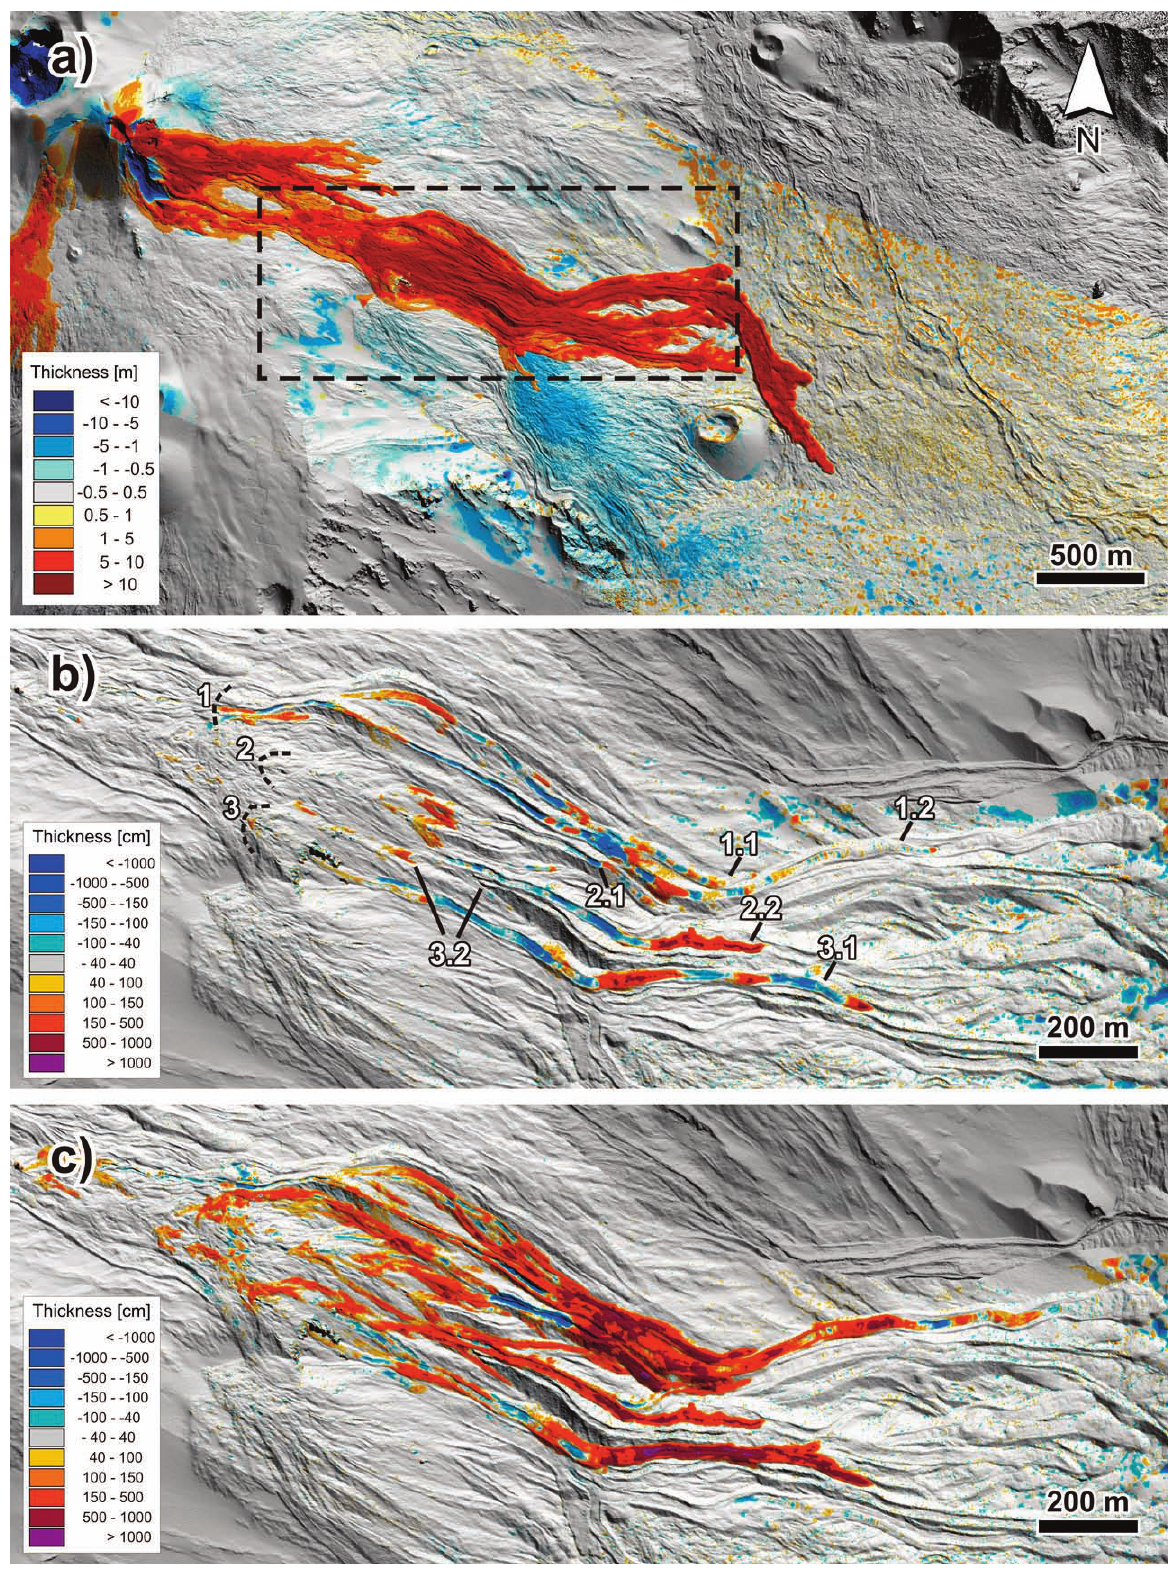
Figure 1. a) 2006-2005 DEM difference map calculated from the LIDAR datasets of INGV-Pisa, showing the extent of the eastern lava field (in warm colors – yellow, orange, red) of the 2006 eruption at the beginning of the 2006 LIDAR survey; b) and c) volumetric changes at the lava-flow field over two different time scales: b) ~2.5 h, between 08:31 a.m. and 11:04 a.m. on November 18, 2006, and c) ~1 day, between 10:04 a.m. on November 17, 2006, and 11:04 a.m. on November 18, 2006. Ephemeral vent zones marked 1, 2 and 3 indicate the main feeding points, with the six active channels labeled accordingly (1.1 to 3.2). b) and c) modified from Favalli et al.